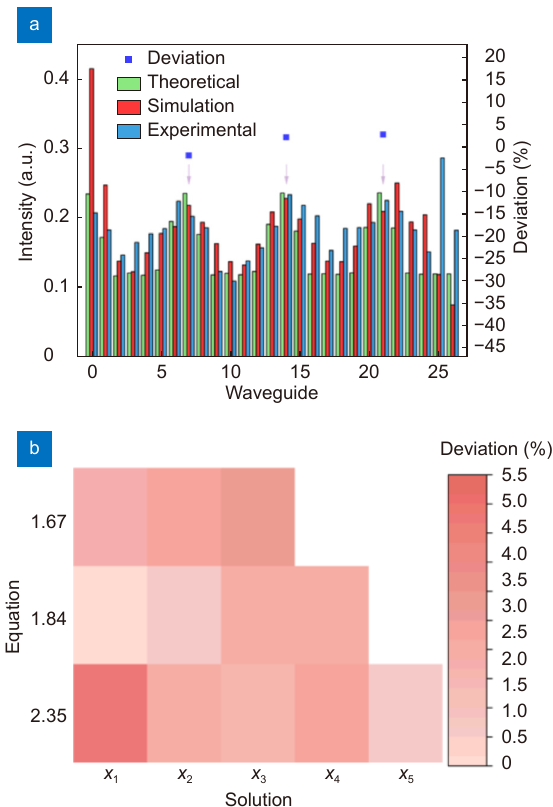
Fig. 3 | All-optical transcendental equation solver. ( a ) Output light intensity distribution in the output waveguides ( k = 1.67). The arrows in the figure correspond to the locations of the solutions. The hori- zontal axis is the number of discrete waveguides, the vertical axis on the left represents the output signal intensity, and the vertical axis on the right gives the deviation between the experimental output signal and the theoretical value. ( b ) A graphic representation of solution de- viation. The horizontal axis labels the individual solutions, and the vertical axis represents three values of the parameter k . The shade of the color indicates the magnitude of the